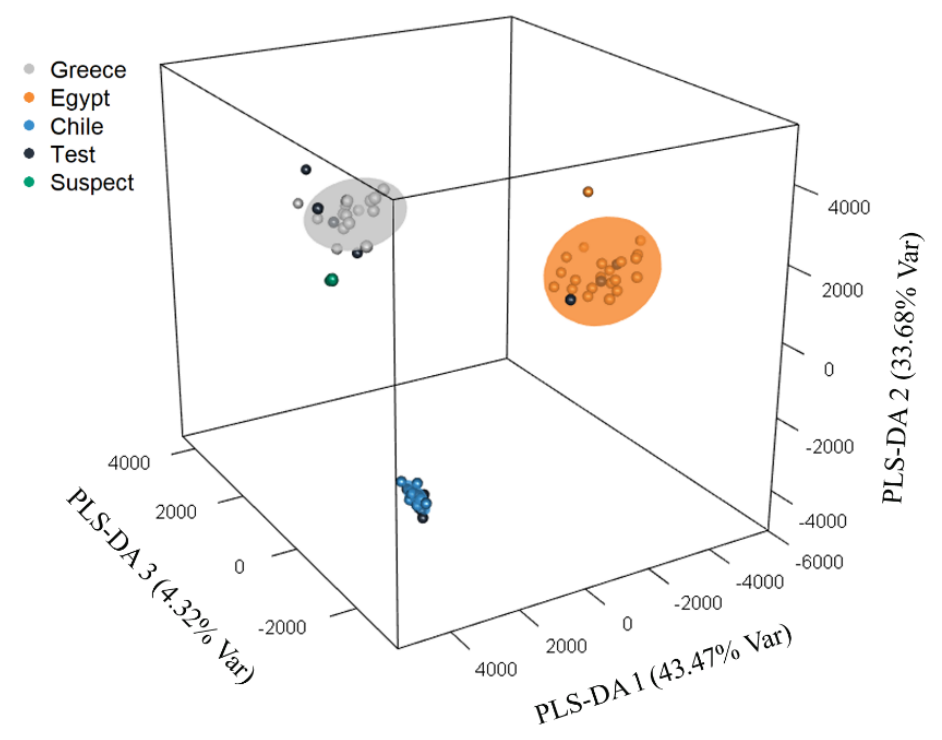
Figure 3. PLS-DA model for the discrimination of Kalamon olive drupes of different geographical origins.